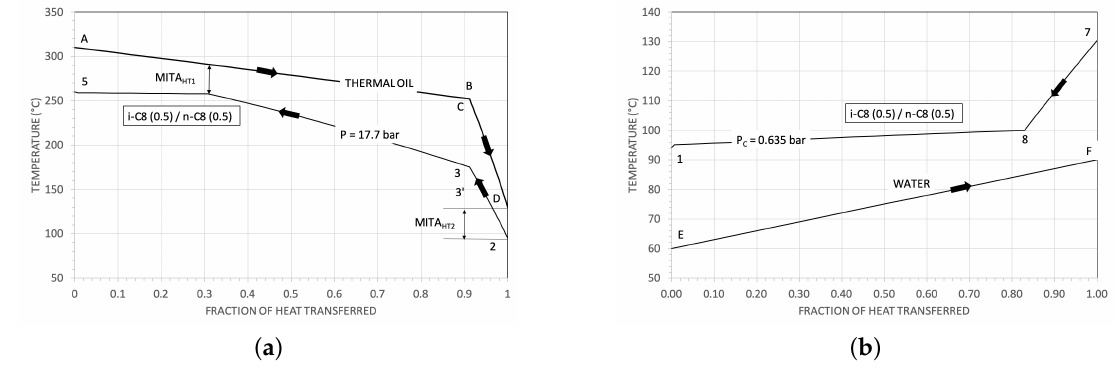
Figure 9. Temperature-Thermal Power Exchanged for the cycle operating with the mixture i-C8 (0.5)/n-C8 (0.5) in the ( a ) High Temperature heat exchangers. ( b ) Condenser.